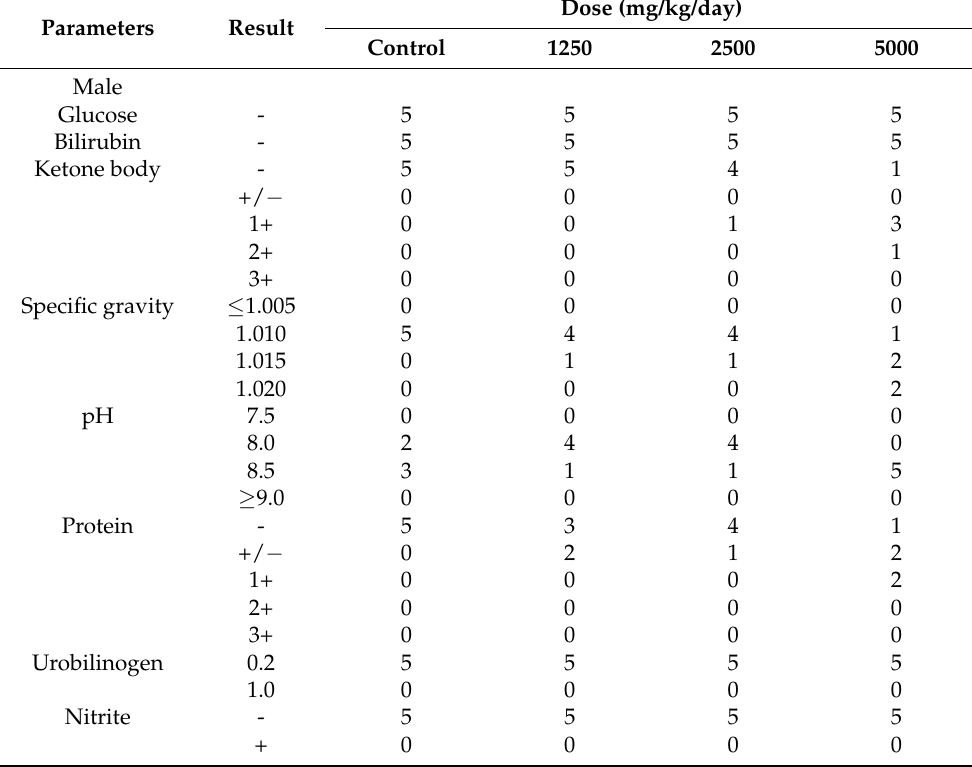
Table 5. Urinalysis in 13 weeks repeated oral dose toxicity of WG extract in male